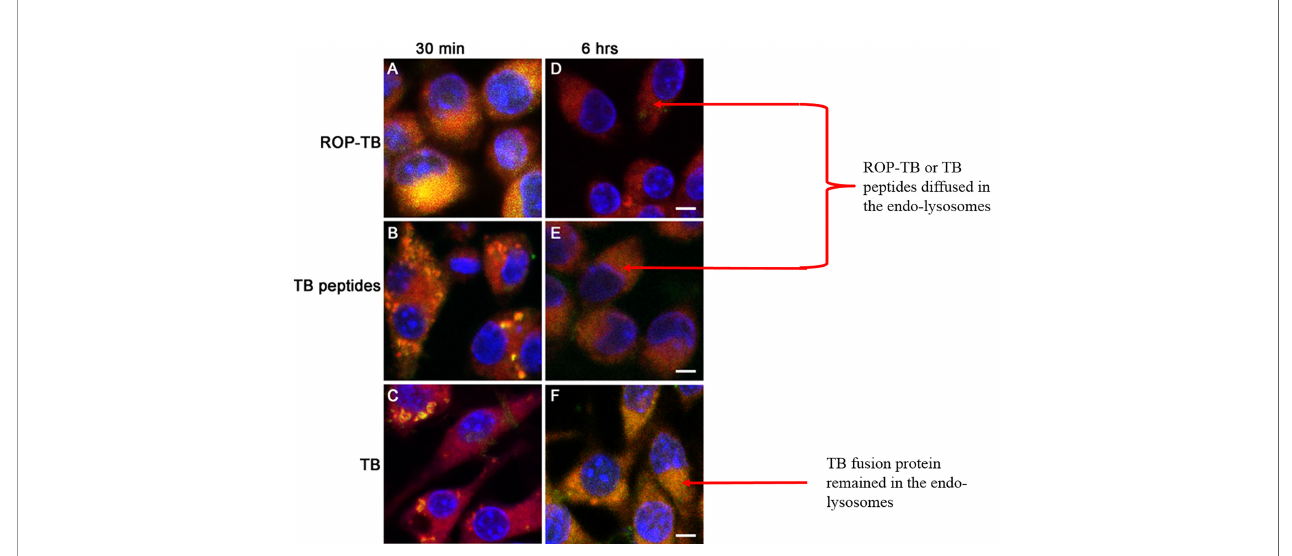
FIGURE 2 | Intracellular localization of ROP-TB, TB peptides, and TB protein in DC2.4 cells. DC2.4 cells were incubated with green fl uorophore labeled ROPTB, TB peptides, or TB protein for 30 min and 6 hours followed by confocal microscopy analysis (63x objective). DC2.4 cells were co-stained with lysotracker red for visualizing endo-lysosomes. The nucleus was counterstained with DAPI. (A – C) ROP-TB, TB peptides, and TB fusion protein are internalized by DC2.4 within 30 min of incubation and are largely co-localized within endolysosomes compartment. (D, E) ROP-TB and TB peptides diffused in the endo-lysosomes after 6 hours. (F) TB fusion protein remained in the endo-lysosomes after 6 hours. Scale bar: 10